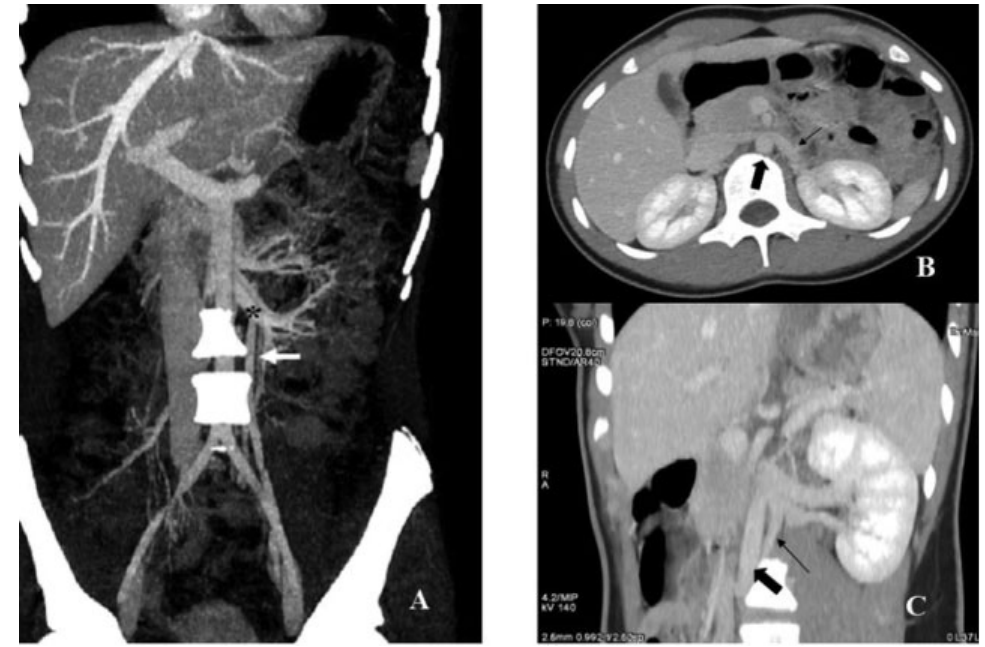
Fig. 1 Abdominal pelvic computed tomography scan with contrast. ( A ) Coronal plane showing a double left renal vein (LRV) with a retroaortic component (black star) caudal to the main renal vein and a dilated left ovarian vein (white arrow). ( B ) Transversal plane showing the anterior branch of the LRV (thin arrow) and the aorta artery (thick arrow). ( C ) Coronal plane showing the posterior branch of the LRV (thin arrow) and the aorta artery (thick